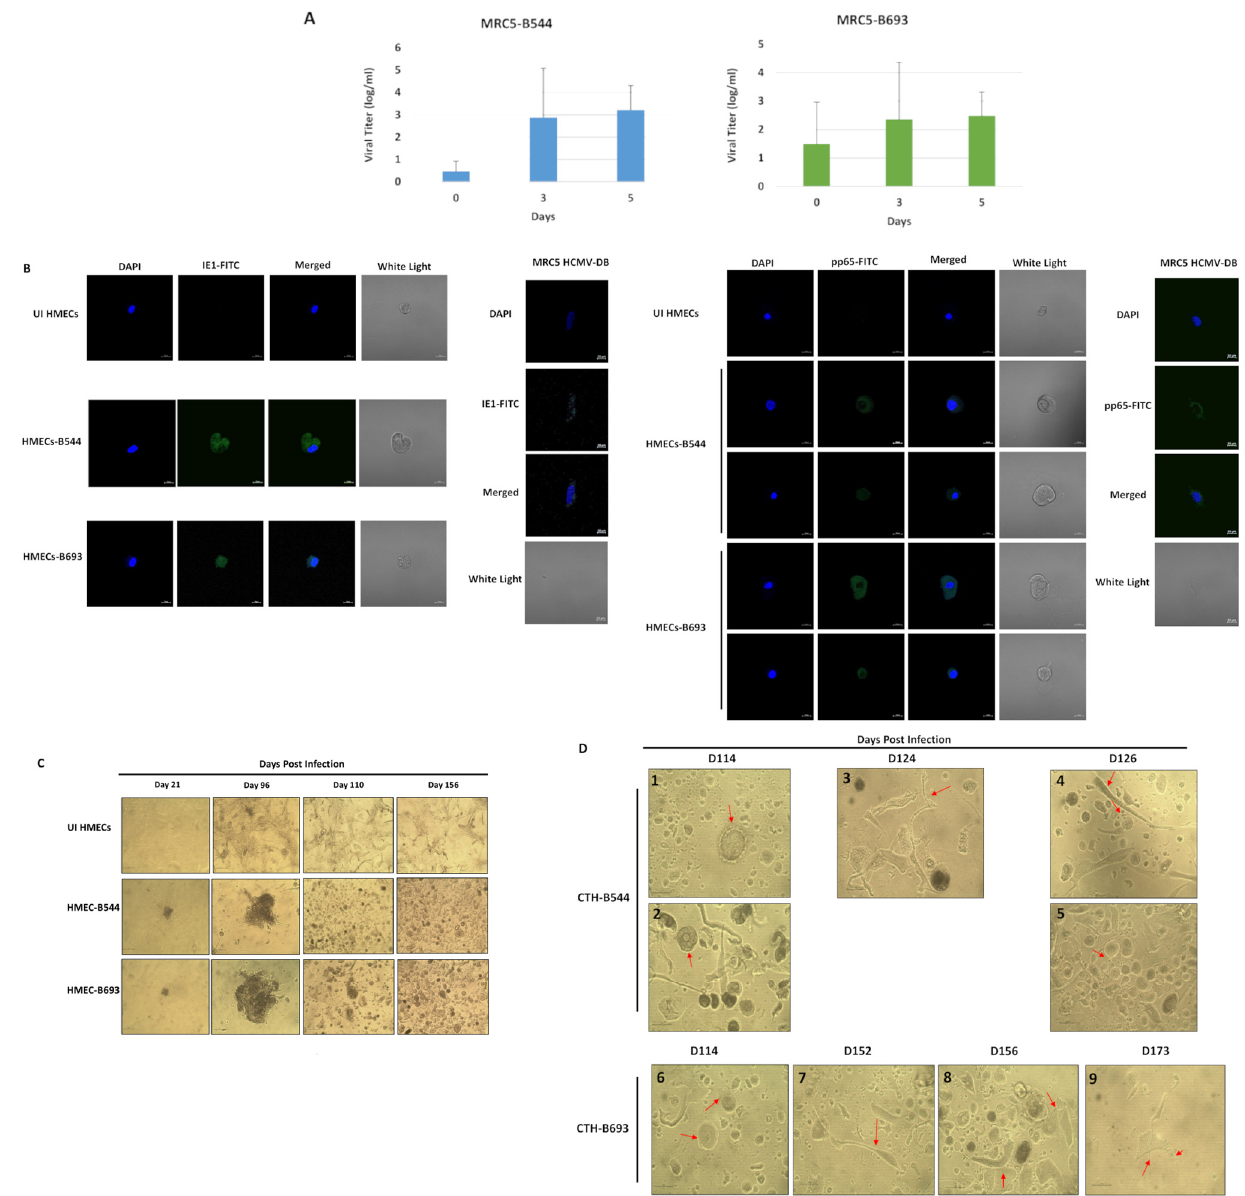
Figure 1. Replication of B544 and B693 strains in MRC5 cultures, and the appearance of morphologically distinct cells following the infection of HMECs with these high-risk strains. ( A ) Time-course of the viral titer in the supernatant of MRC5 infected with the strains HCMV-B544 and HCMV-B693, as measured by IE1-qPCR. ( B ) Confocal microscopic images of HCMV-IE1 and pp65 staining in HMECs infected with HCMV-B544 and HCMV-B693 (day 1 post-infection). Uninfected HMECs were used as controls. Nuclei were counterstained with DAPI; magnification × 63, scale bar 10 µ m. ( C ) HMECs time-course infection with HCMV-B544 and HCMV-B693 strains (MOI = 1). Magnification × 100, scale bar 100 µ m. Uninfected HMECs were used as a control. ( D ) Presence of giant cells with blastomere-like morphology (1 and 6), mesenchymal cells (4 and 7), lipid droplet-packed cells (3, 8, and 9), cells displaying multiple nuclei (2) as well as cell budding (4, 5, and 6), and cells with filopodia protrusions (9) in CTH-B544 and CTH-B693 cells. The inverted light microscope scale bar represents 100 μ m; magnification ×200.